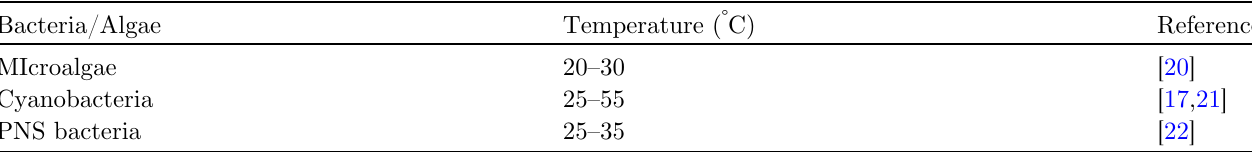
Table 7. Most ef fi cient performing temperatures using microorganisms.